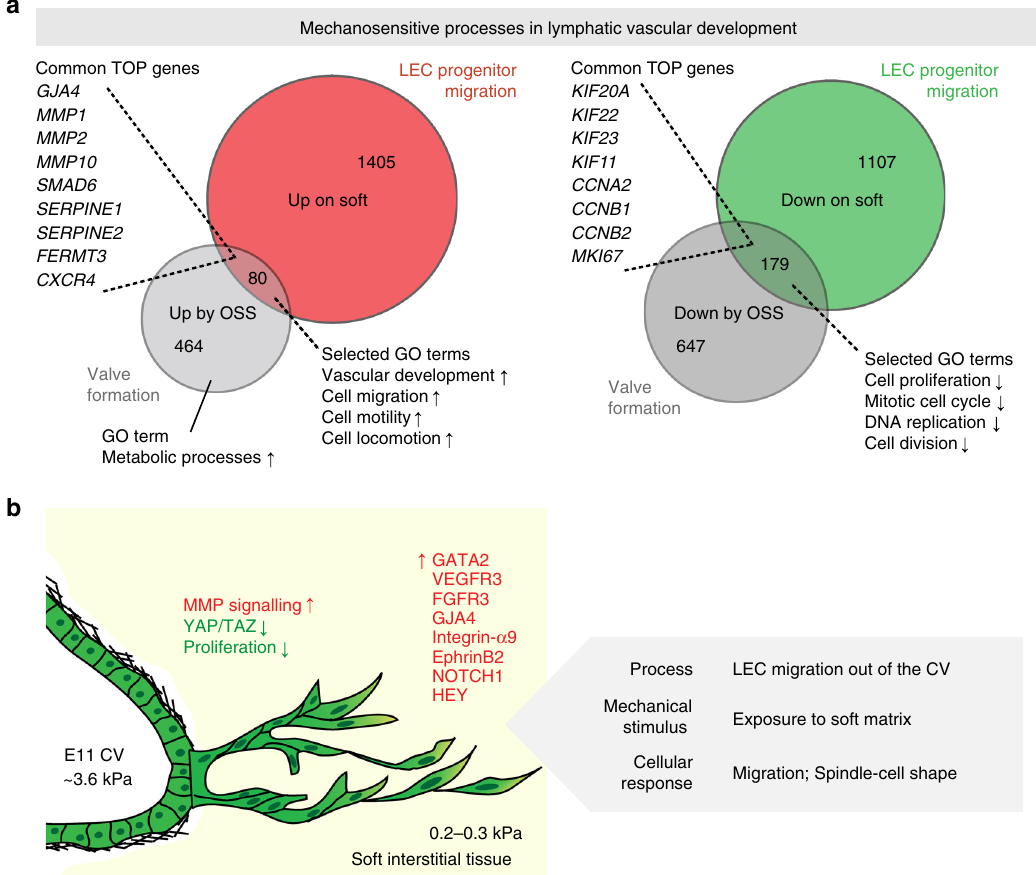
Fig. 7 Common and unique mechanoresponses during lymphatic vascular morphogenesis. a Area-proportional Venn diagrams of up- or downregulated genes in LECs grown on stiff or soft matrix (mimicking conditions of venous-derived LEC migration during the formation of fi rst lymphatic vessels), and LECs subjected to static or oscillatory fl ow (mimicking initiation of valve formation 14,16 ) conditions. Common TOP genes and selected GO terms are listed. b Schematic of venous-derived LEC migration out the CV. Exposure of venous-derived LECs to soft matrix induces GATA2-dependent increase in VEGFR3 expression and LEC migration. TOP regulated genes (red, up; green, down) are